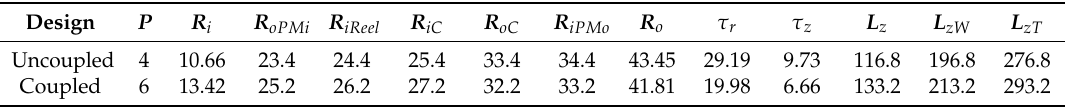
Table 5. Number of poles and dimensional results for the uncoupled and the coupled model. Dimensions are presented in